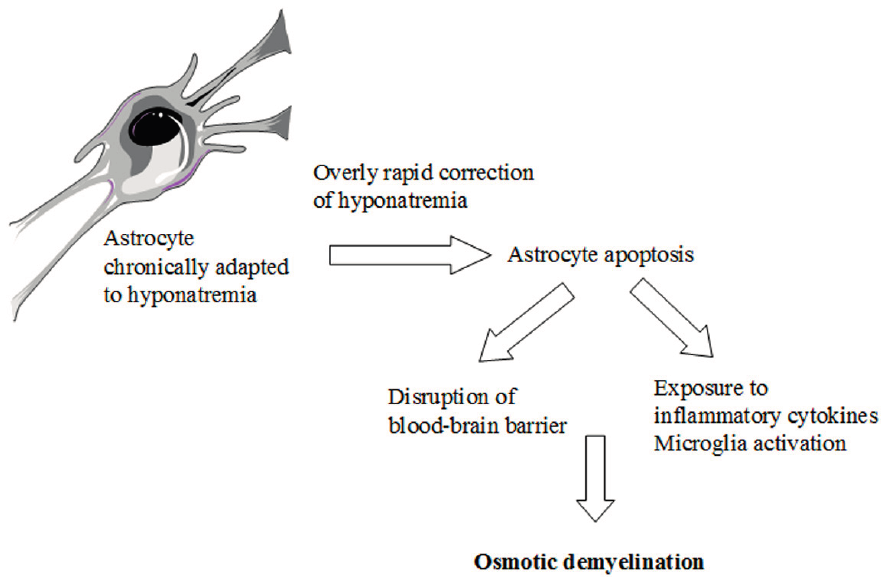
Figure 3. Pathophysiology of ODS. Schematic representation of the possible events caused by an overly rapid correction of chronic